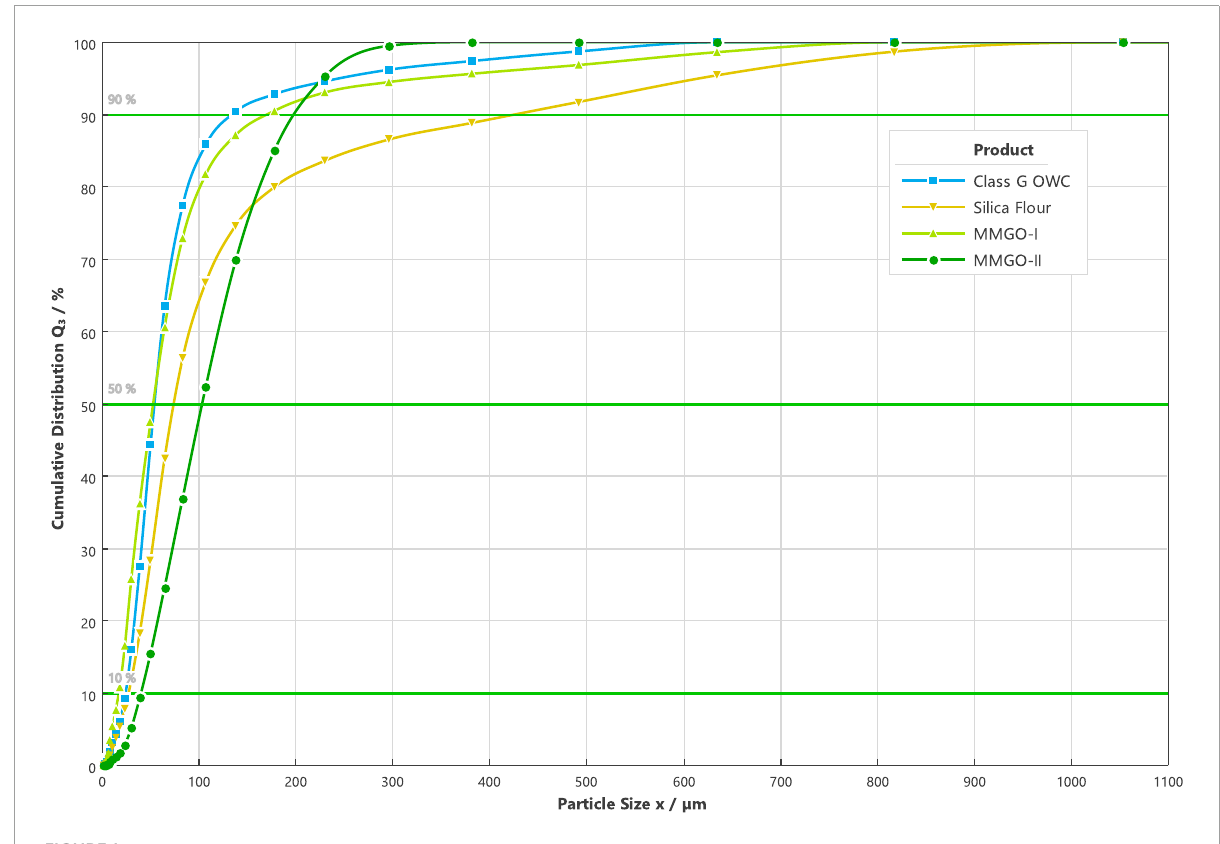
FIGURE 1 Particle size analysis result of source materials (OWC cement, magnesium oxides, and silica